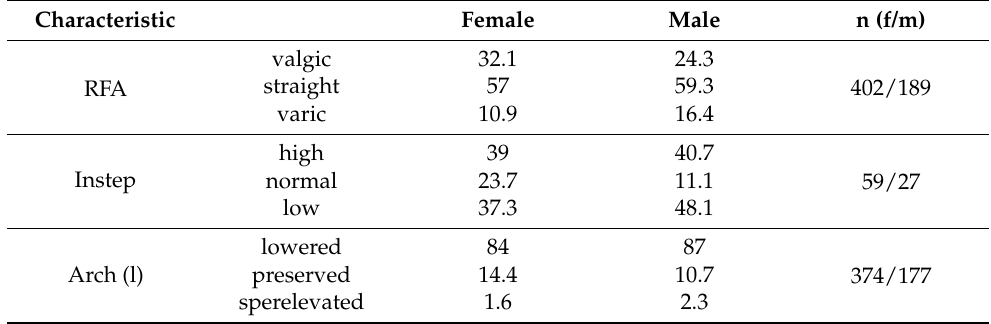
Table 5. Examinations of the foot by gender in percent.